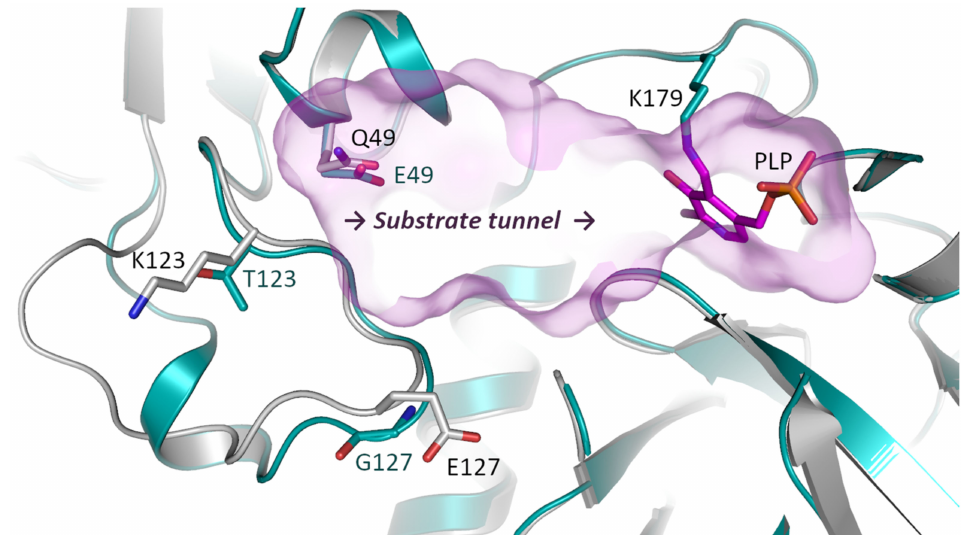
Figure 2. Targeted residues in the substrates tunnel area of ATA-Afu and ATA-Gze. The proteins ATA-Afu and ATA-Gze are shown as cyan and white cartoons, respectively. The oxygen and nitrogen atoms of different residues are colored red and blue. The carbon atoms of the cofactor PLP are colored purple. The substrate tunnel is colored light purple. The figure was created using PyMOL 2.3.0